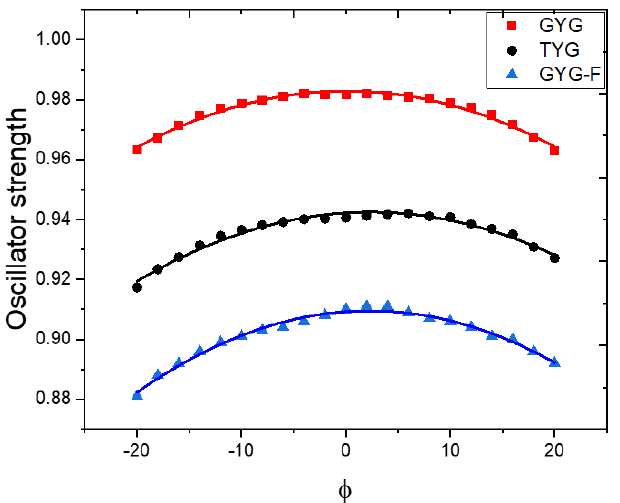
Figure 6. Oscillator strength for the S 0 –S 1 transition in the isolated TYG, GYG, and fluorinated GYG (GYG-F in which one –CH 3 is replaced with –CF 3 ) chromophores along torsional angle φ (all other degrees of freedom are relaxed) computed with ω B97X-D/aug-cc-pVDZ.